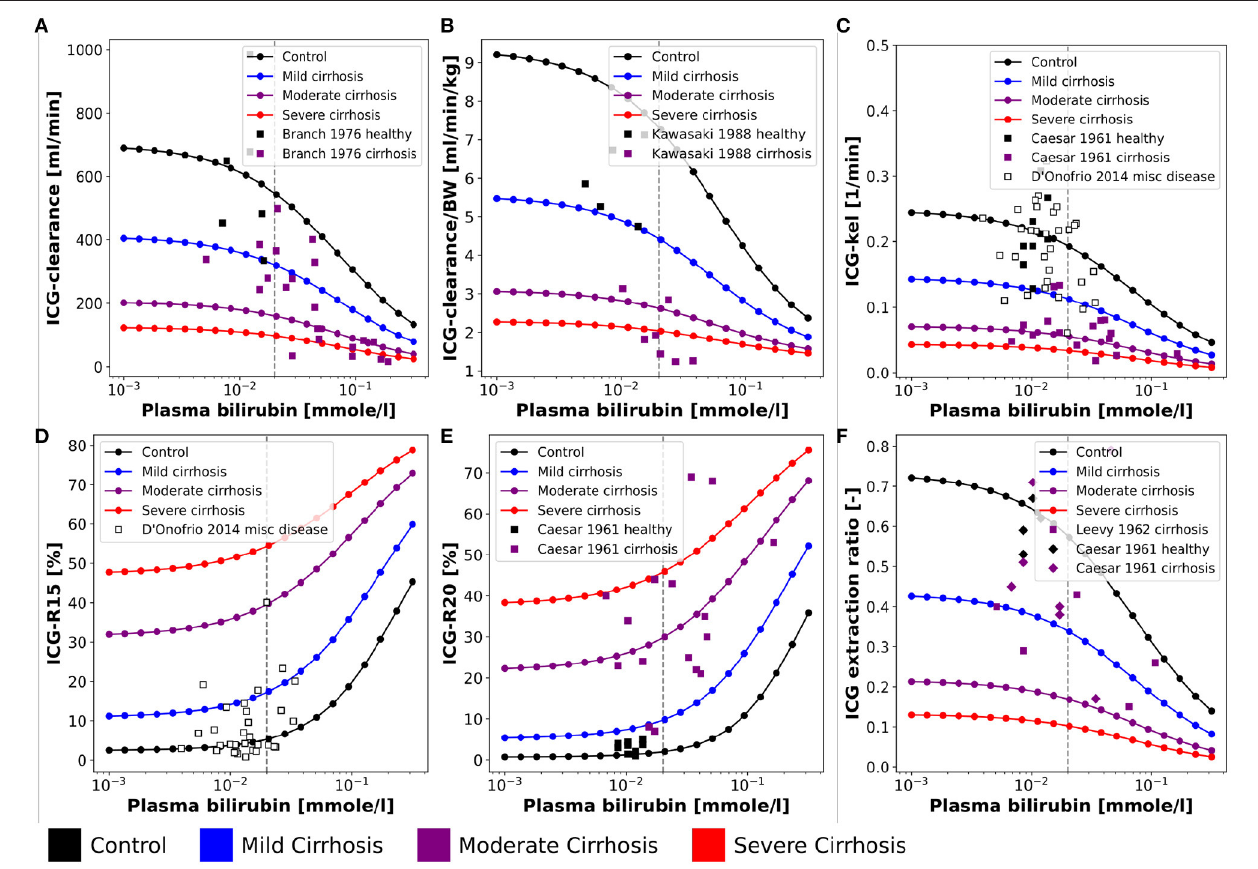
FIGURE 4 | Effect of plasma bilirubin on ICG parameters: For model validation multiple plasma bilirubin experiments were simulated and compared to clinical data sets. Simulations were performed for four different cirrhosis degrees (see section 2.1): Black: control, blue: mild cirrhosis: purple: moderate cirrhosis, red: severe cirrhosis. (A) Dependency of ICG-clearance on the plasma bilirubin concentration. Clinical data of control and cirrhotic subjects from Branch et al. (1976). (B) Dependency of ICG-clearance per kg body weight on the plasma bilirubin concentration. Clinical data of control and cirrhotic subjects from Kawasaki et al. (1988). (C) Dependency of ICG-kel on the plasma bilirubin concentration. Clinical data of control and cirrhotic subjects from Caesar et al. (1961). Clinical data of subjects with other liver diseases from D’Onofrio et al. (2014). (D) Dependency of ICG-R15 on the plasma bilirubin concentration. Clinical data of subjects with other liver diseases from D’Onofrio et al. (2014). (E) Dependency of ICG-R20 on the plasma bilirubin concentration. Clinical data of control and cirrhotic subjects from Caesar et al. (1961). (F) Dependency of ICG extraction ratio on the plasma bilirubin concentration. Clinical data of control and cirrhotic subjects from Caesar et al. (1961) and Leevy et al.